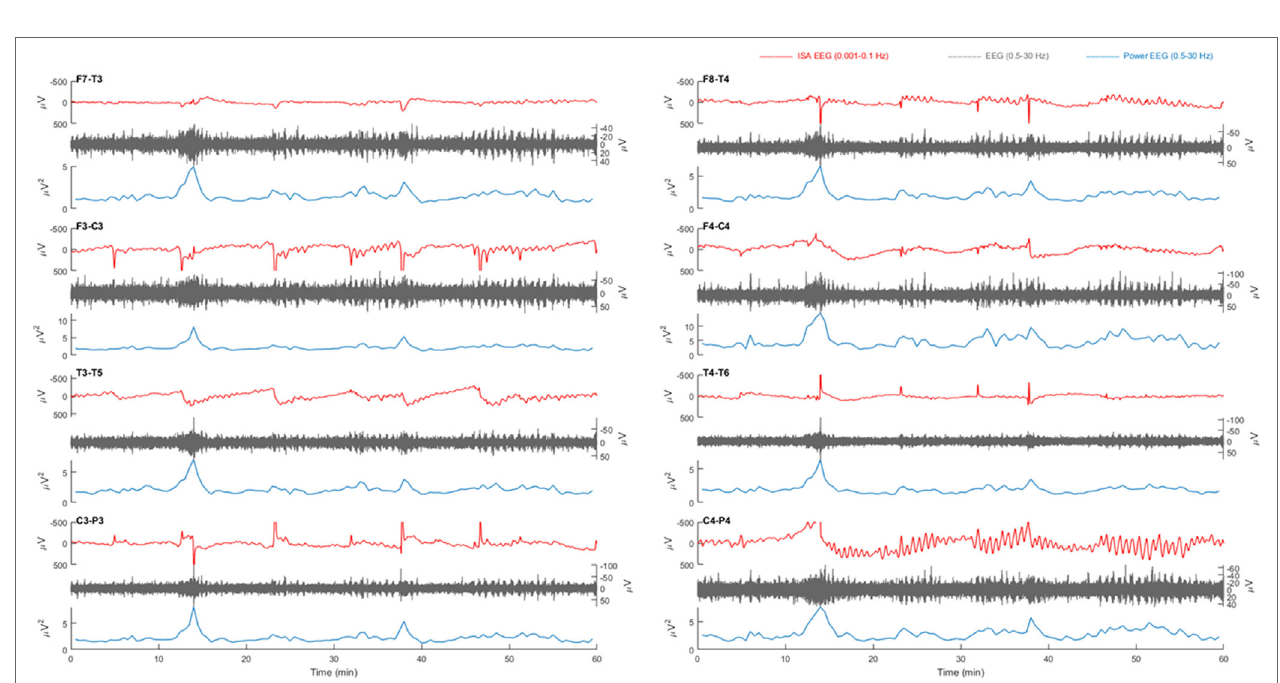
FigUre 4 | Example of a 1 h electroencephalography (EEG) overview from a patient with traumatic brain injury. Source derivations for four electrodes (F7, F3, P3, and T5) of the left hemisphere and four electrodes (F8, F4, P4, and T6) of the right hemisphere are displayed. Oscillatory infraslow activity (ISA, 0.001–0.1 Hz, red) is present over the right hemisphere. The ISA is accompanied by simultaneous fluctuations of faster activity (0.5–30 Hz, gray), which is visible in the power of this frequency band (blue). The fluctuations of faster activity result from waxing and waning of lateralized periodic discharges.